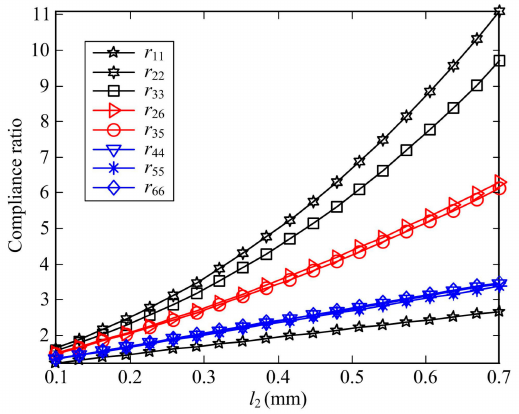
Figure 11. Compliance ratio of DEAF and DEA as a function of l 2